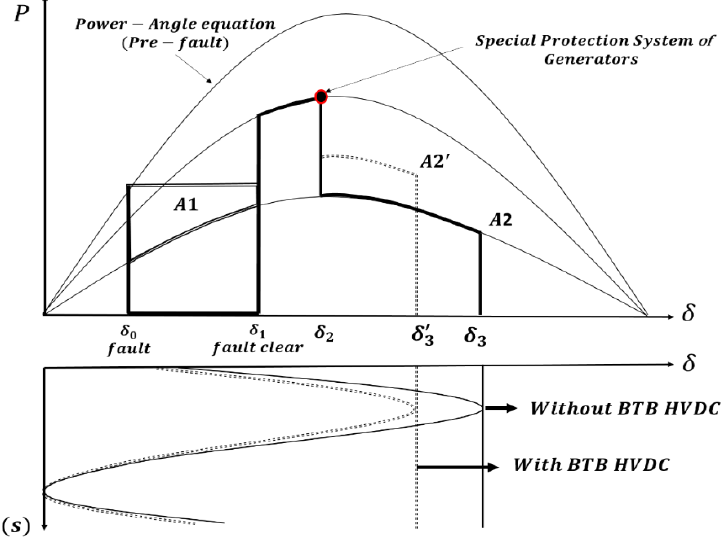
Figure 6. Equal Area Criterion with the second power control strategy.